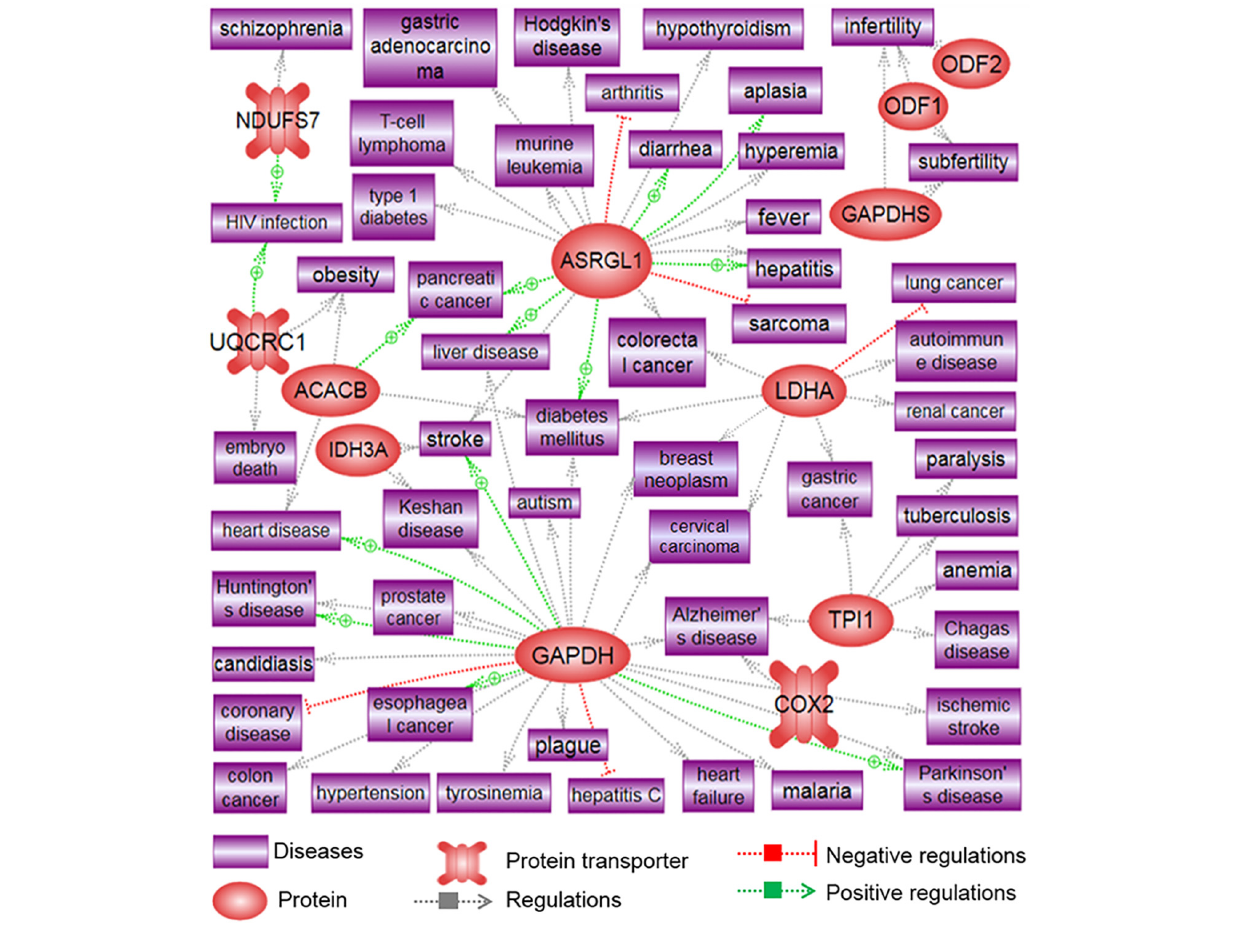
profiles of two tubulin isoforms α 8 and β 2B. Use of